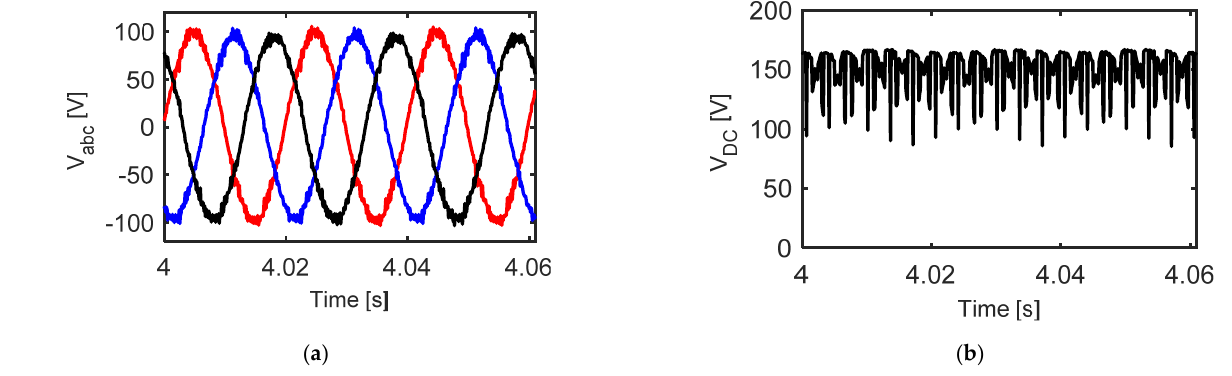
Figure 15. Experimental results ( a ) phase input voltages and ( b ) the voltage of DC